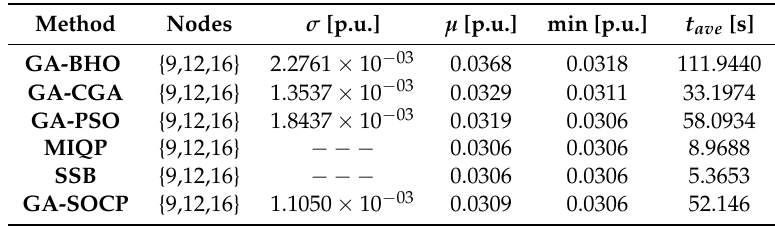
Table 3. Comparison of different approaches in the 21-node test feeder. Method Nodes σ